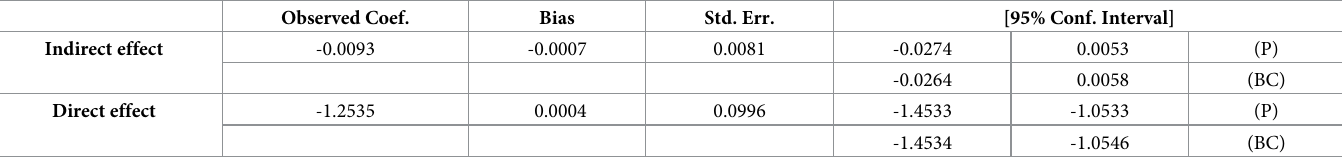
Table 5. Test results of the mediating effect of Roa on technological innovation with the Bootstrap method. Observed Coef.